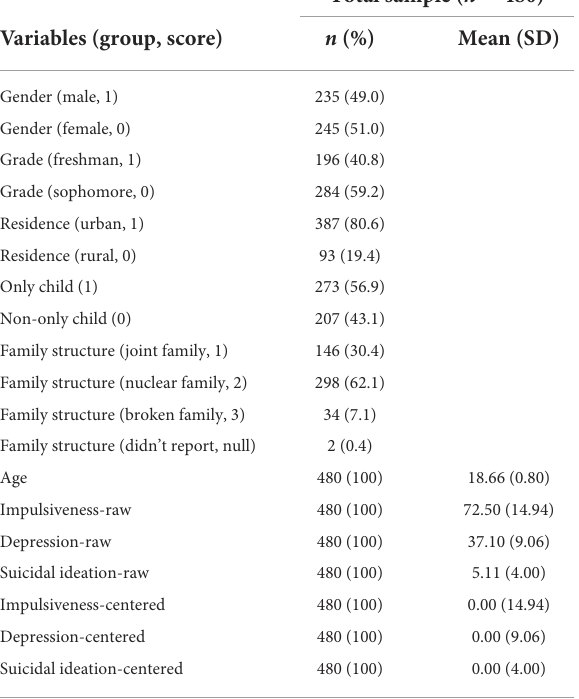
TABLE 1 Demographic characteristics and descriptive